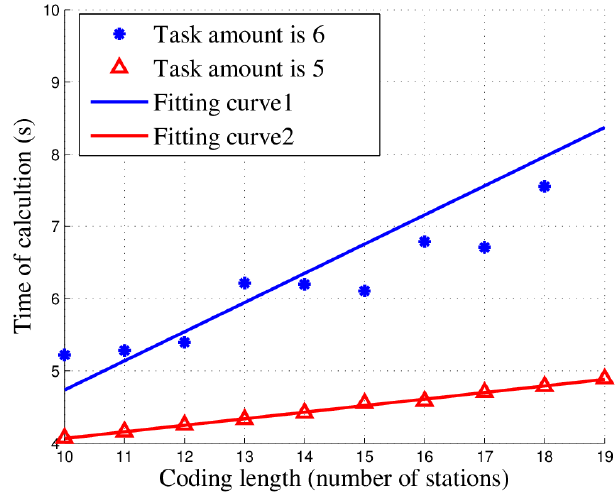
Figure 13. Relationship between time complexity and coding length.